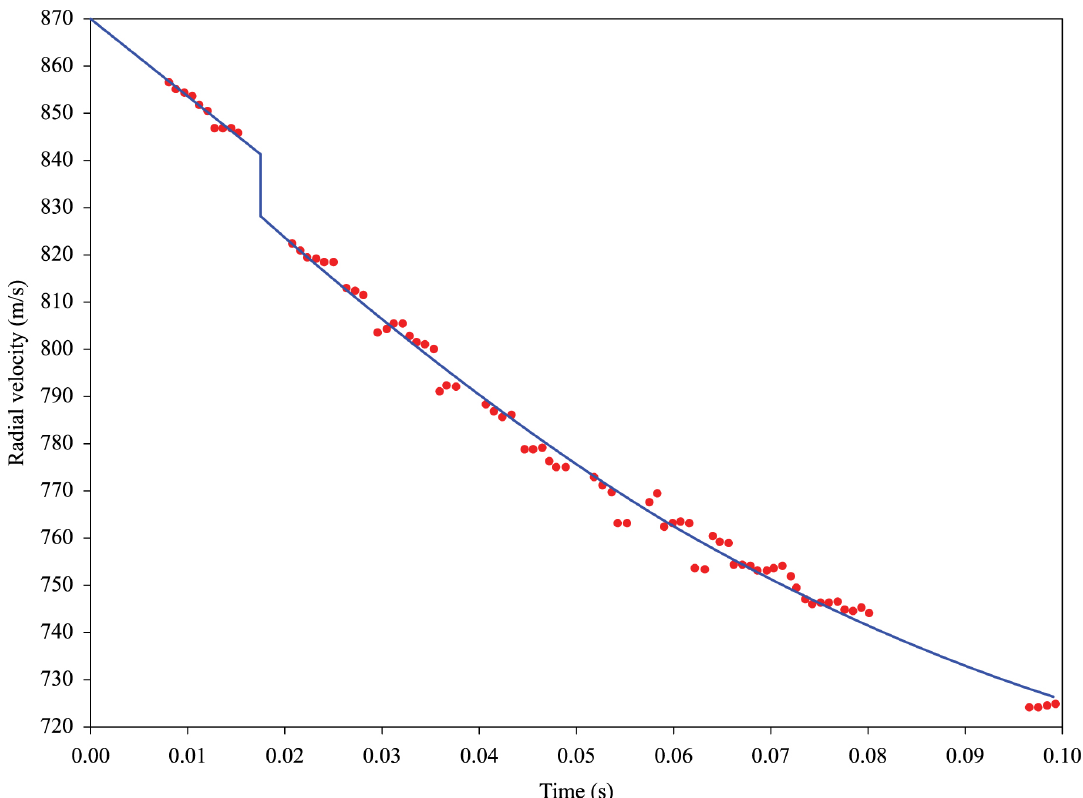
Figure 8. Velocity attenuation experimental points and adjusted curve for the ballistic test of a sisal Table 2. Impact and residual velocities together with internally dissipated energy in individually ballistic tested MAS components. MAS Component